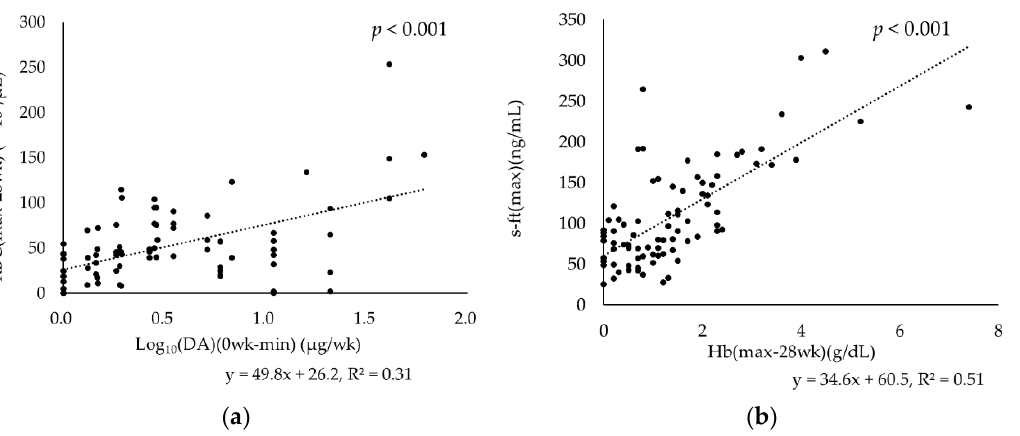
Figure 4. Relationship of ( a ) the change in RBC with DA dose and ( b ) serum ferritin levels with change in Hb levels.